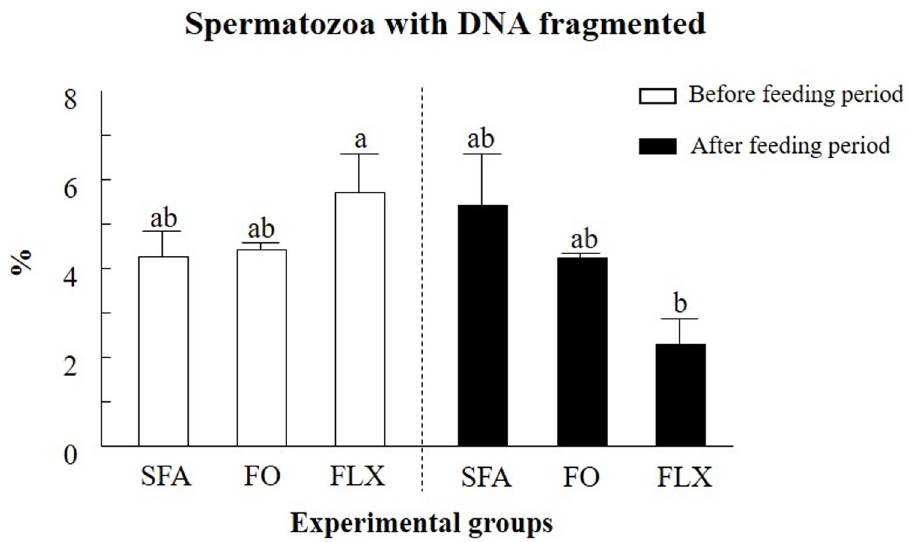
Fig 8. The effect of omega-3 sources flaxseed and fish oil on the DNA fragmentation index. The percentage of DNA fragmentation for pooled samples from each experimental group: saturated fatty acid (SFA; control), fish oil (FO) and flaxseed oil (FLX) taken from before and after the feeding trial is presented. Data are presented as the mean ± SEM. Different letters above the columns indicate significant differences relative to the SFA group at each time point ( P <